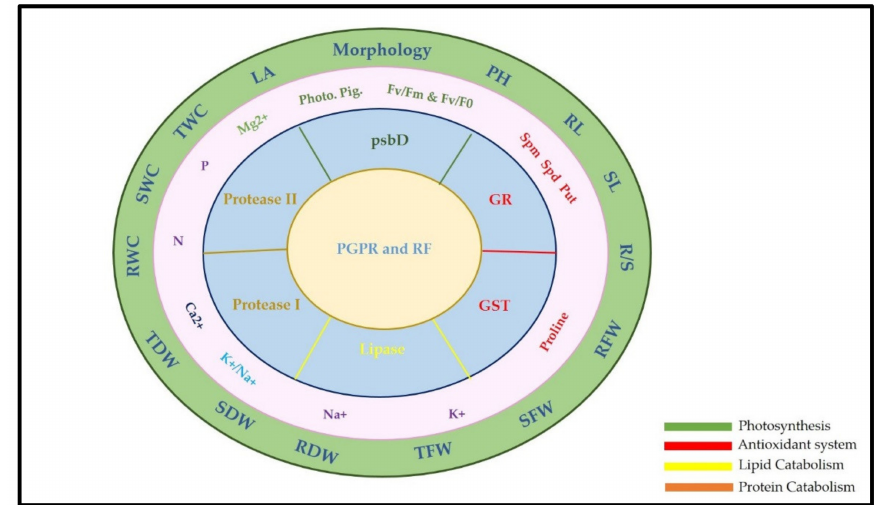
Figure 5. Proposed modulation of systemic resistance in salt-stressed Solanum melongena L. shoots and roots due to inoculation with selected PGPR and RF. Colored box refers to physiological aspects; psbD related to photosynthesis in green; GR and GST related to antioxidant system in red; lipase related to lipid catabolism in yellow; protease I and protease II related to protein catabolism in